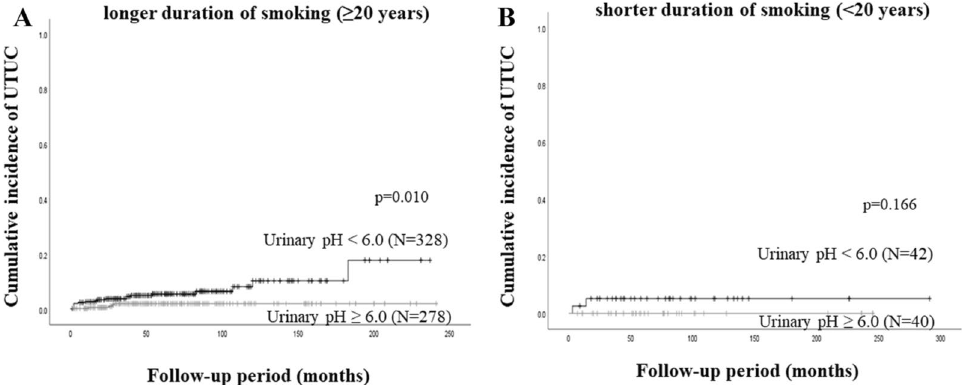
Figure 3. Cumulative incidence of UTUC recurrence stratified by urinary pH levels in patients who had a smoking history and ( A ) a longer duration of smoking (≥ 20 years) or ( B ) shorter duration of smoking (< 20 years).